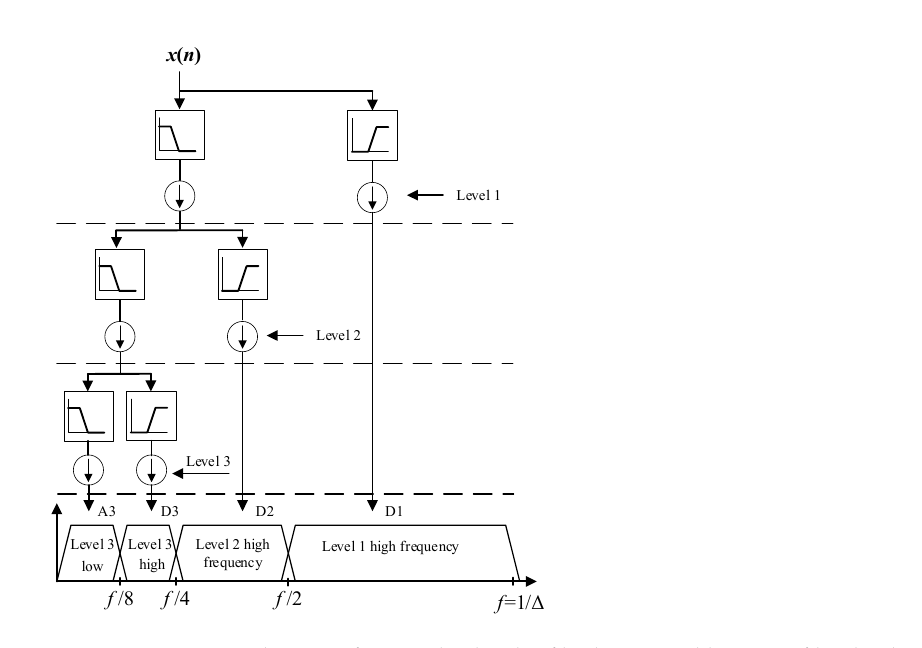
t t Figure 3. Signal digitization with discrete sampling window method. In our study, we apply the discrete wavelet transform (DWT) [20] to decompose the collected sensor signal in each sampling window S(t (cid:2919) ) . The discrete wavelet transform decomposes the given signal into a number of sets, where each set is a time series of coef-